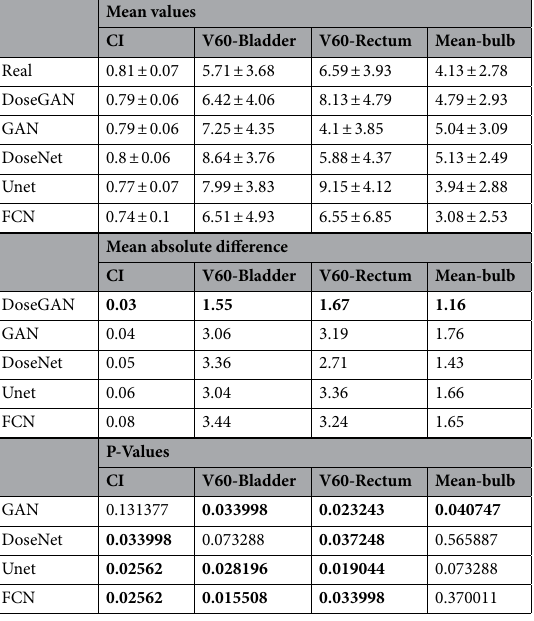
Table 2. The mean values, mean absolute differences between the real dose and each algorithm, and the comparator p-values between DoseGAN and each alternative algorithm are shown for the CI, V 60 of the bladder, V 60 of the rectum, and mean dose of the bulb. Bold font indicates the least difference between the real and predicted dose and statistically significant p-values.